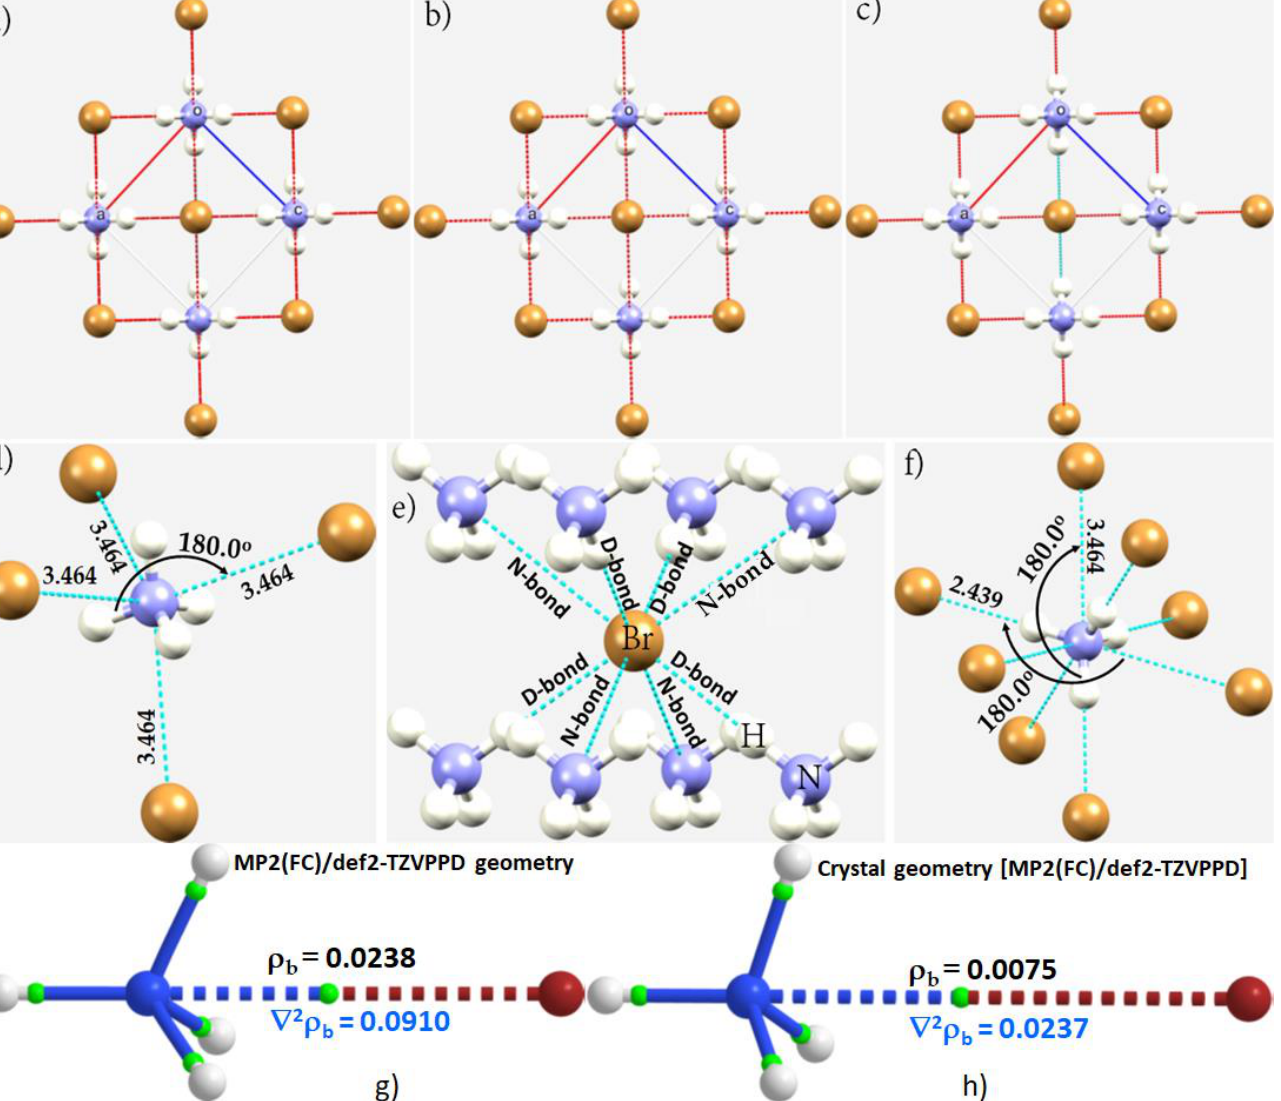
Figure 10. Three views of the crystal of tetradeuterioammonium bromide IV-LT, ND 4 Br (space group: P 4̅ 3m , ICSD ref. 26577 [103]) showing ( a ) combined D···Br deuterium bonds and N···Br pnictogen bonds, ( b ) N···Br pnictogen bonds, and ( c ) D···Br deuterium bonds. Illustration of the nature of the local nature of multi-furcated charge-assisted intermolecular bonding topologies: ( d ) ND 4+ as four pnictogen bond donors; ( e ) Br − as four D-bond and four N-bond acceptors; and ( f ) illustration of the nature of directionality for each of the four D and four N bond donors. Bond lengths and bond angles are in Å and degrees, respectively. The dotted lines represent inter-ionic interactions. Atom type is shown in ( e ). ( g , h ) MP2(FC)/def2-TZVPPD level QTAIM-based molecular graph for the ion-pair NH 4 Br, obtained on its MP2(FC)/def2-TZVPPD gas-phase geometry and as in the crystal, respectively; both these graphs show bond paths as sticks and dotted lines in atom color (N—blue; Br—dark-red; H—white grey), bond critical points as tiny spheres between atomic basins in green, and values (in a.u .) of charge density ρ b and the Laplacian of the charge density ∇ 2 ρ b at the N ··· Br bond critical